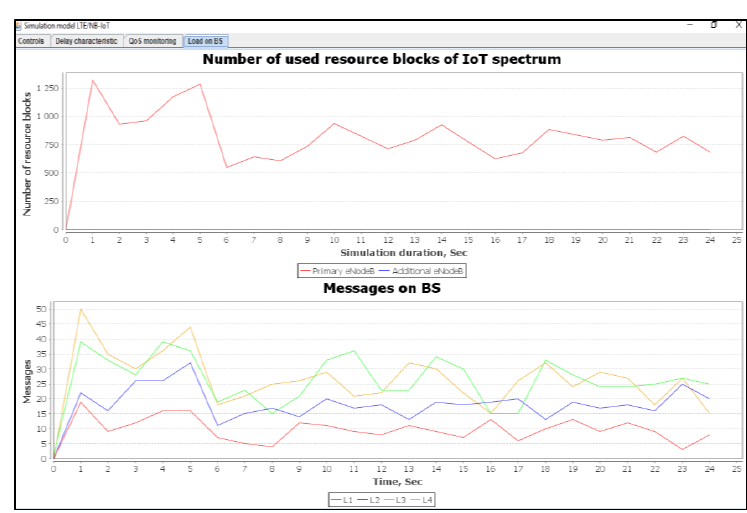
Figure 15. Number of IoT spectrum resource blocks and transmitted messages ratio with different priorities (average load of IoT controller ρ = 18%).